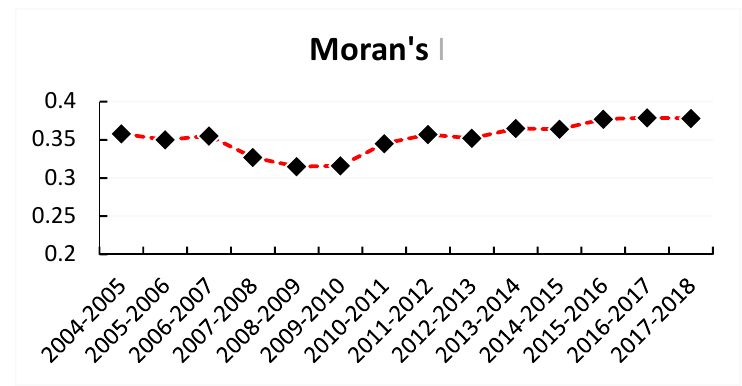
Figure 2. Global Moran’s I of HCR Concentration in China